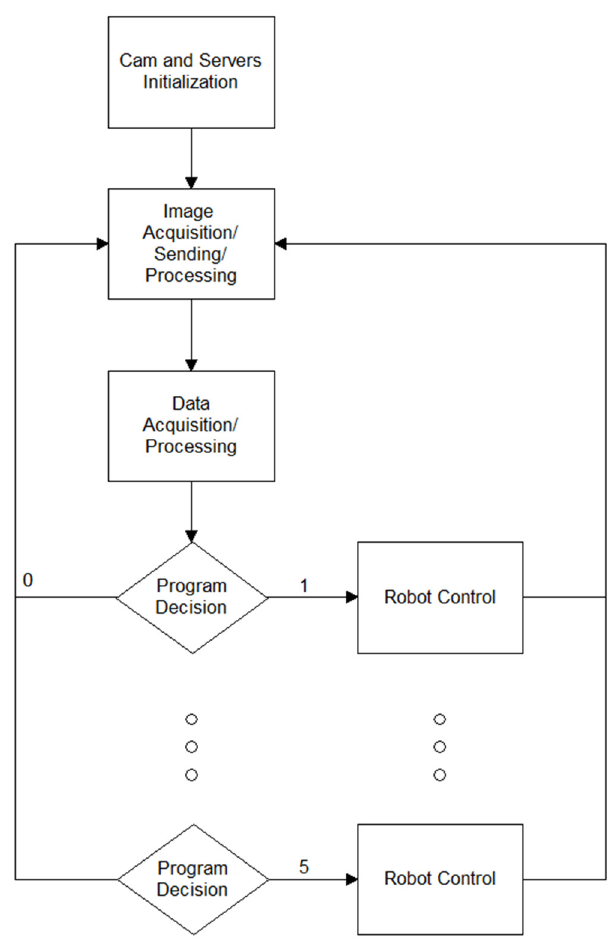
Figure 7. The flowchart of our proposed algorithm.